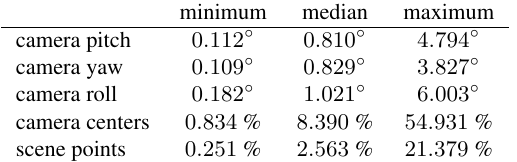
Table 3: Deviations of three estimated camera orientation angles, camera projection centers and scene point locations of the R EAL data set w. r. t. the approximate solution. Locations are in percent compared to the coordinate range of all